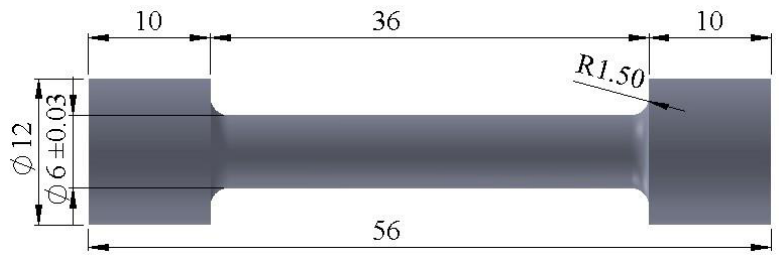
Figure 3. Dimensions of the tensile test specimen; all dimensions are in mm.